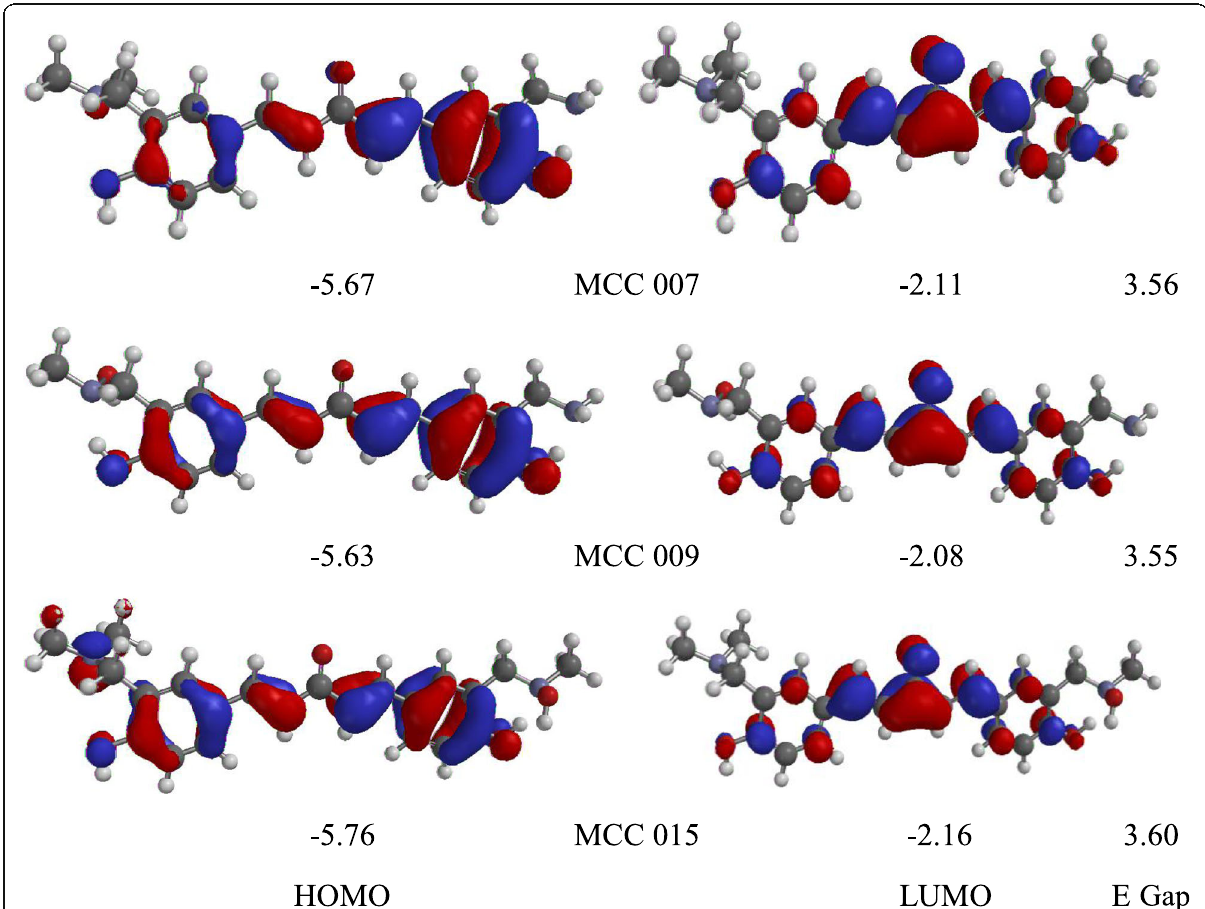
Fig. 3 The orbital distribution and energy (in eV) of HOMO and LUMO for MCC 007, MCC 009, and MCC 015 computed at the B3LYP/6-311G* level in the gas